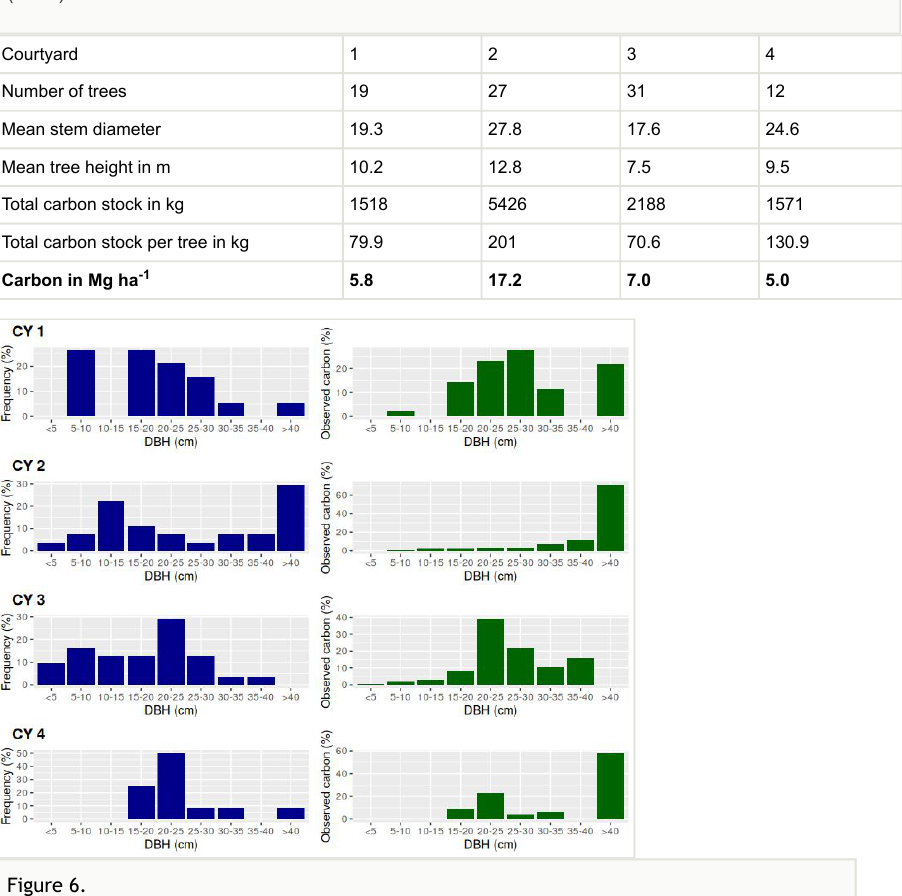
Frequency and observed carbon of trees in the